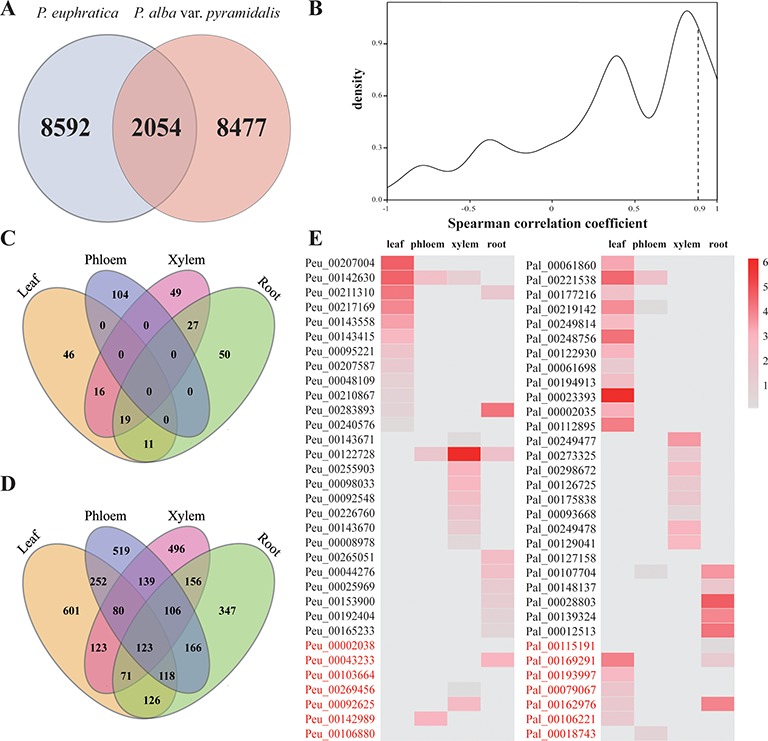
Comparison analysis of lncRNAs in the two species of poplar. (A) Homologous lncRNAs in two poplars. (B) Spearman correlation coefficient of homologous lncRNAs. (C) Distribution of lncRNAs with high expression level in P. euphratica but not in P. alba var. pyramidalis in four tissues. (D) Distribution of species-specific DE lncRNAs in P. euphratica in four tissues. (E) The expression patterns of homologous tissue-specific expressed lncRNAs. lncRNAs with red color indicate homologous lncRNAs expressed in different tissues.